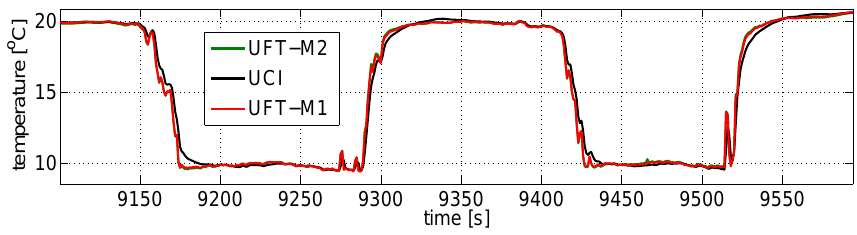
Fig. 5. Comparison of 1Ss − 1 temperature records from UFT-M1, UFT-M2 and UCI in the course of two consecutive porpoises.